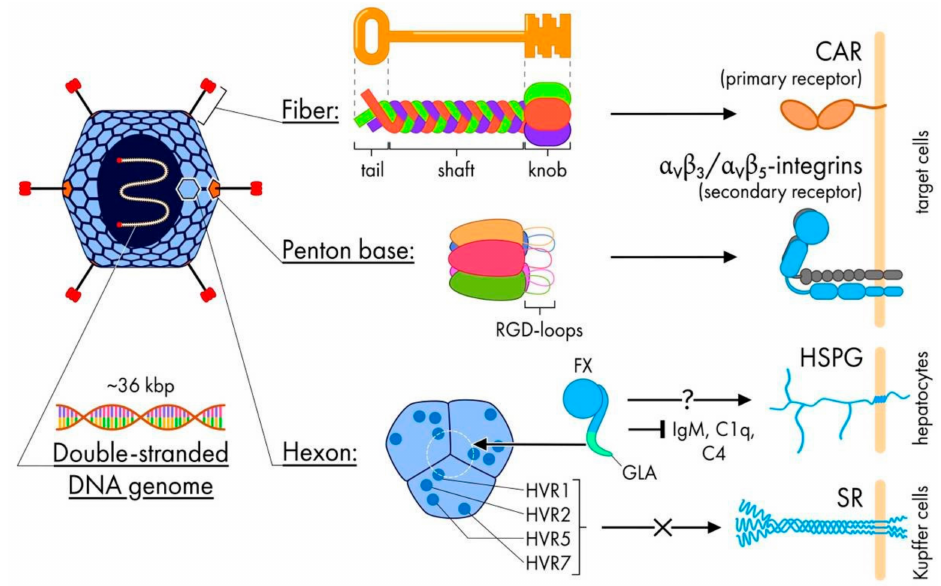
Figure 1. Ad6 structure and function of three main capsid proteins. The Ad6 fiber is the first main capsid protein which is responsible for interaction with target cells. The interaction happens via binding of the Ad6 fiber knob to Coxsackie and Adenovirus receptor (CAR). Next, the Penton base directly binds to α v β 5/ α v β 3 integrins, leading to the internalization of Ad6. The γ -carboxyglutamic acid (GLA) domain of the Hexon protein binds to blood factors (e.g., coagulation factor X (FX)). FX protects virions from natural IgM and complement and can bridge coated viral particles to hepatocyte Heparan Sulfate Proteoglycans (HSPGs) promoting hepatocyte transduction, which is especially im- portant upon systemic administration. The overall low charge of hexon hypervariable regions (HVRs) results in poor Ad6 uptake by scavenger receptors (SR) on Kupffer cell and other macrophages.